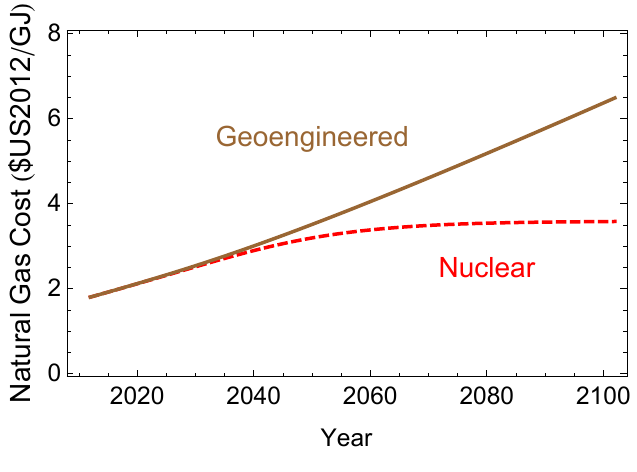
Figure 5. Natural gas wellhead cost with nuclear-led decarbonization (dashed curve), versus a geoengineeered outcome with stratospheric sulfur injection along with subsequent extensive carbon sequestration (solid curve).